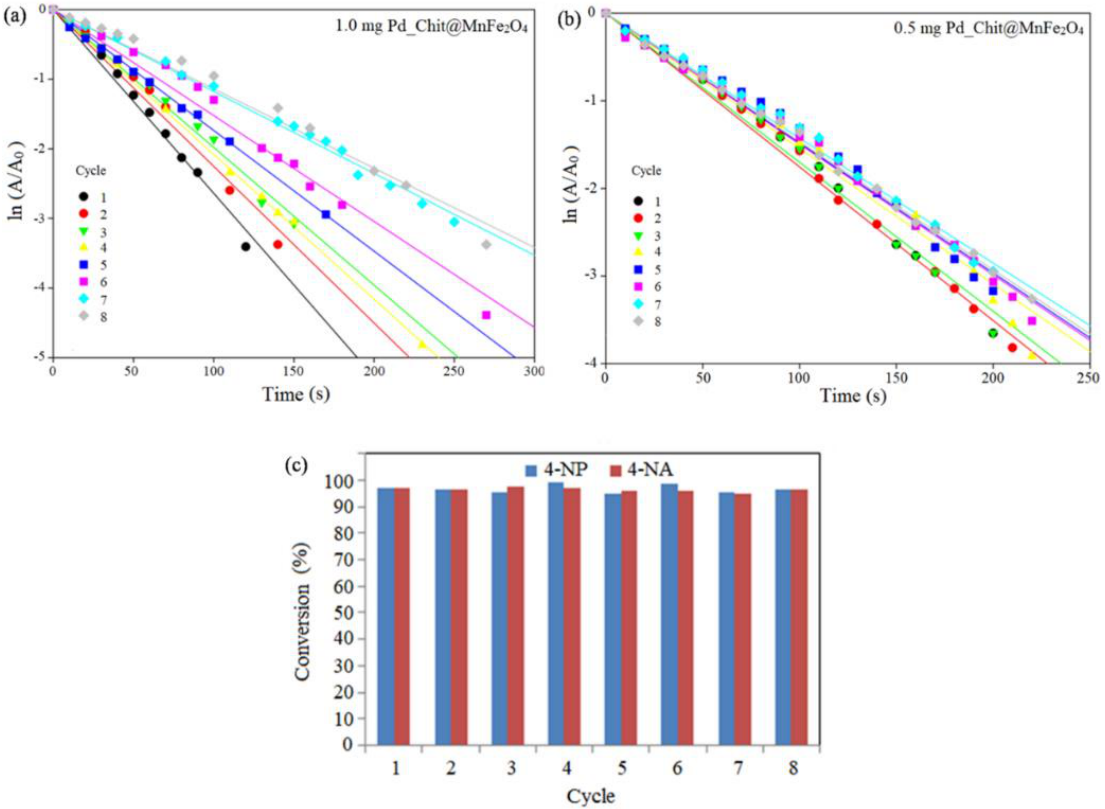
Figure 5. Reusability of Pd − Chit@MnFe 2 O 4 in( a ) 4-NP and ( b ) 4-NA reductions and ( c ) conversion of 4-NP and 4-NA reduction.